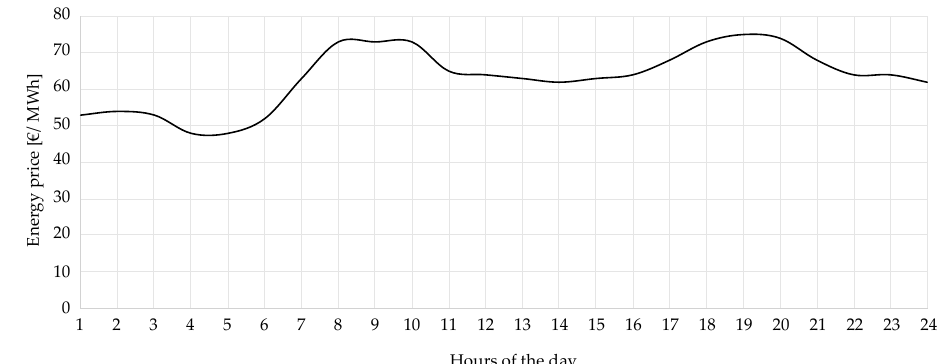
Figure 8. Case study: daily energy prices.